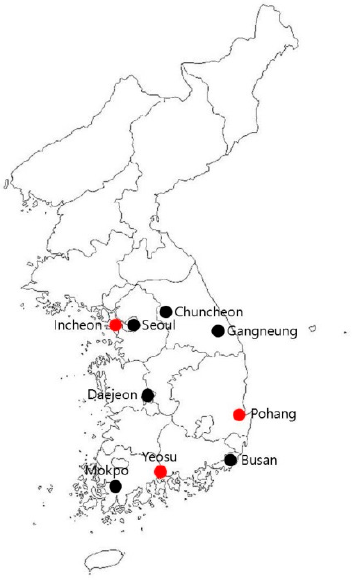
Figure 1. Geographical locations of 9 observation points where underground temperature by depth is provided.